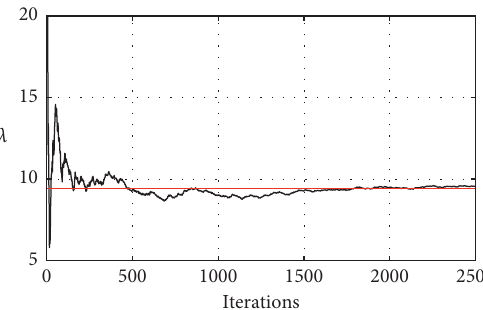
Figure 14: Estimation of the Lyapunov exponent. Red line: convergence mean